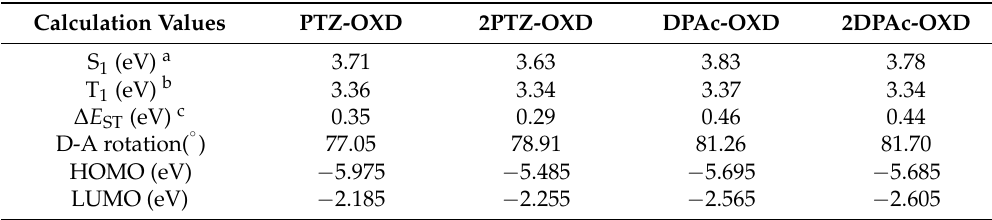
Figure 3. Calculated Frontier molecular orbital distribution. Table 2. Calculation data of four dopant